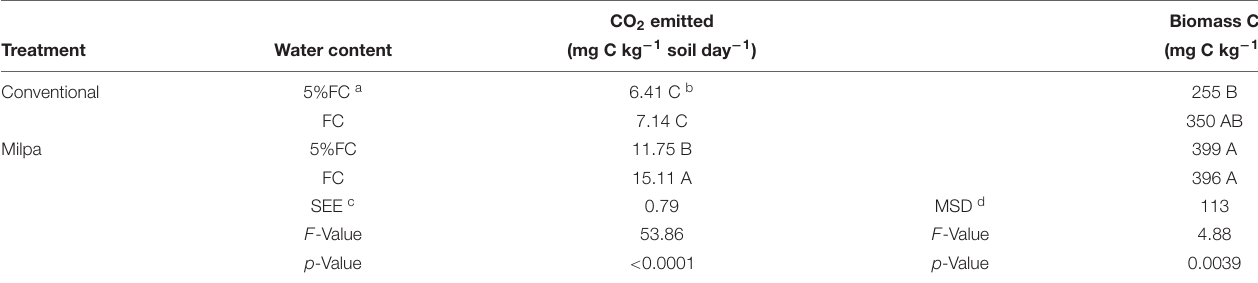
TABLE 3 | The CO 2 production rate and microbial biomass C in soil cultivated conventionally, i.e., conventional tillage, crop residues removal, chemical fertilizer and herbicide application and monoculture of maize ( Zea mays L.), or an organic milpa system, i.e., zero tillage, retention of crop residues, organic fertilizer application,